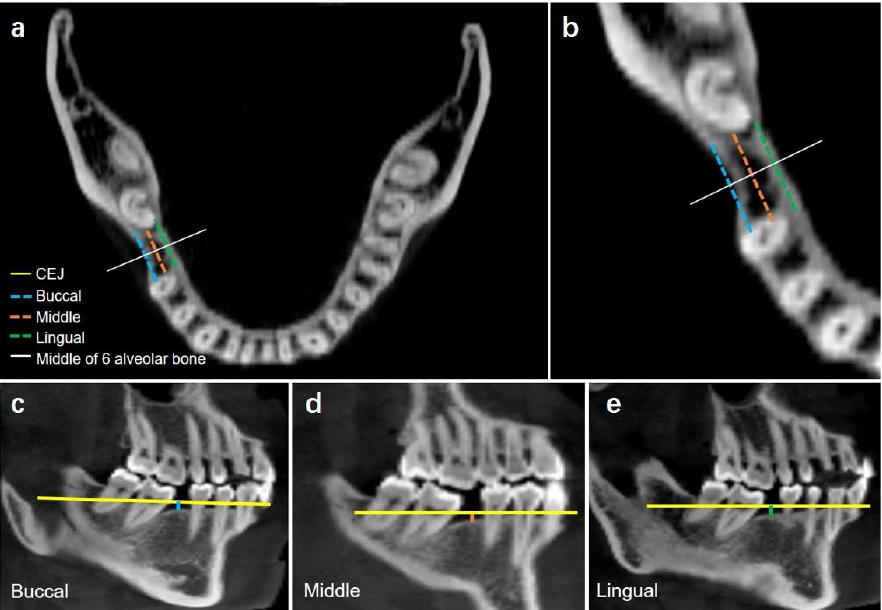
Figure 2. ( a ) Vertical alveolar bone levels of missing mandibular first molar. Coronal section showing the buccal, middle, and lingual sides of the missing first molar region. ( b ) Magnification. ( c ) Buccal vertical bone loss (mm): shortest distance (blue line) from the CEJ line (yellow line) to the alveolar crest in the middle of 6 alveolar bone region (white line). ( d ) Middle vertical bone loss (mm): shortest distance (orange line) from the CEJ line (yellow line) to the alveolar crest in the middle of 6 alveolar bone region (white line). ( e ) Lingual vertical bone loss (mm): shortest distance (green line) from the CEJ line (yellow line) to the alveolar crest in the middle of 6 alveolar bone region (white line).